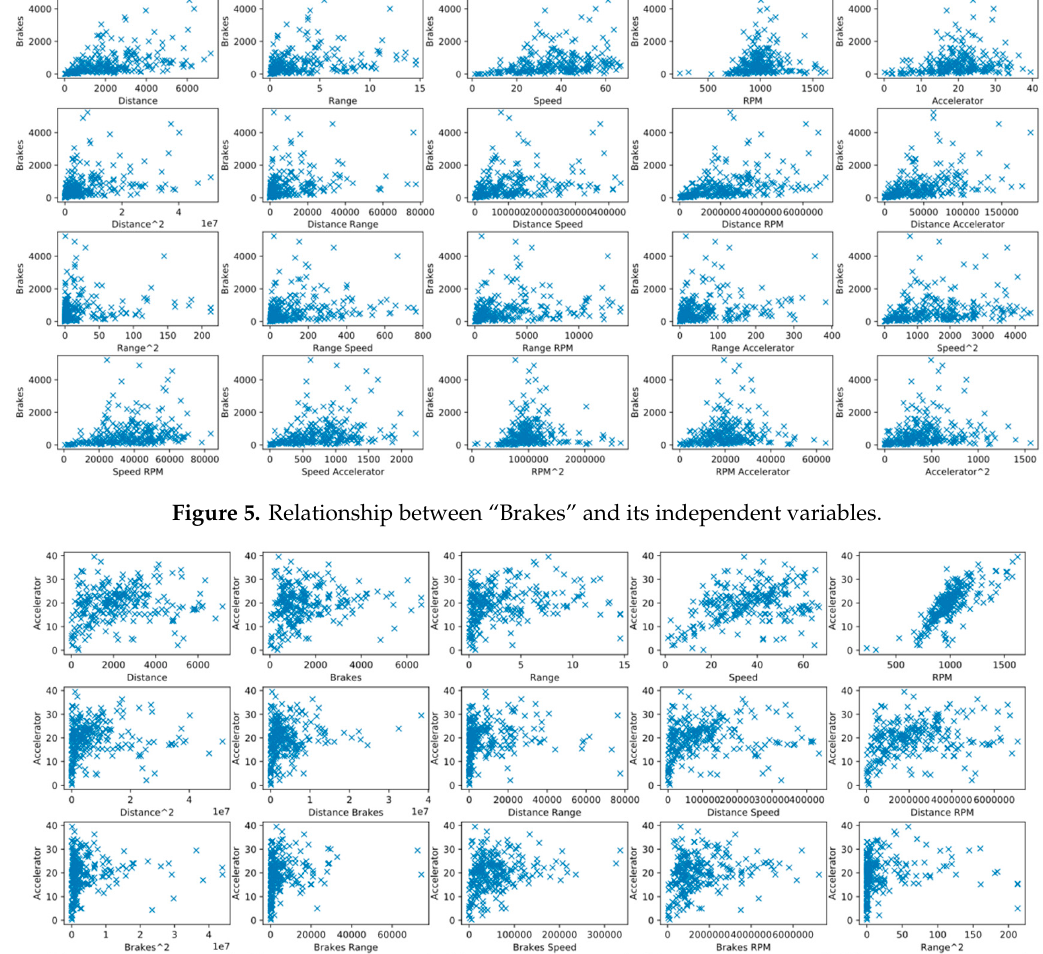
Figure 6. Relationship between “Accelerator” and its independent variables.